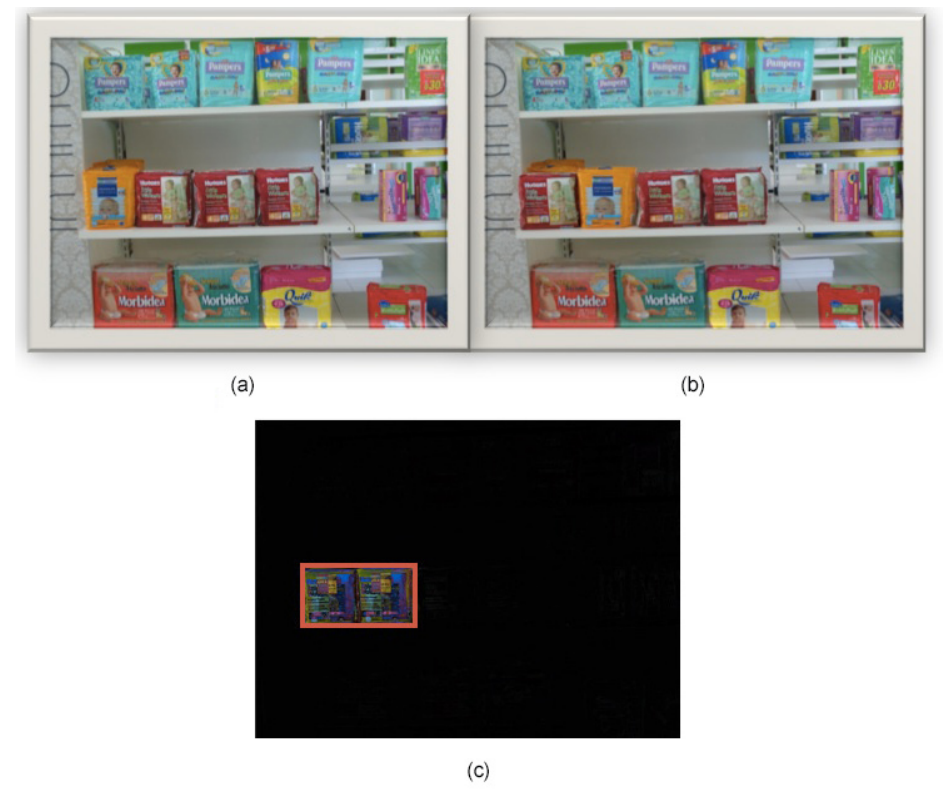
Figure 7. Comparing two planogram images: ( a ) planogram image (base planogram); ( b ) acquired image (actual image); ( c ) visualization of the difference